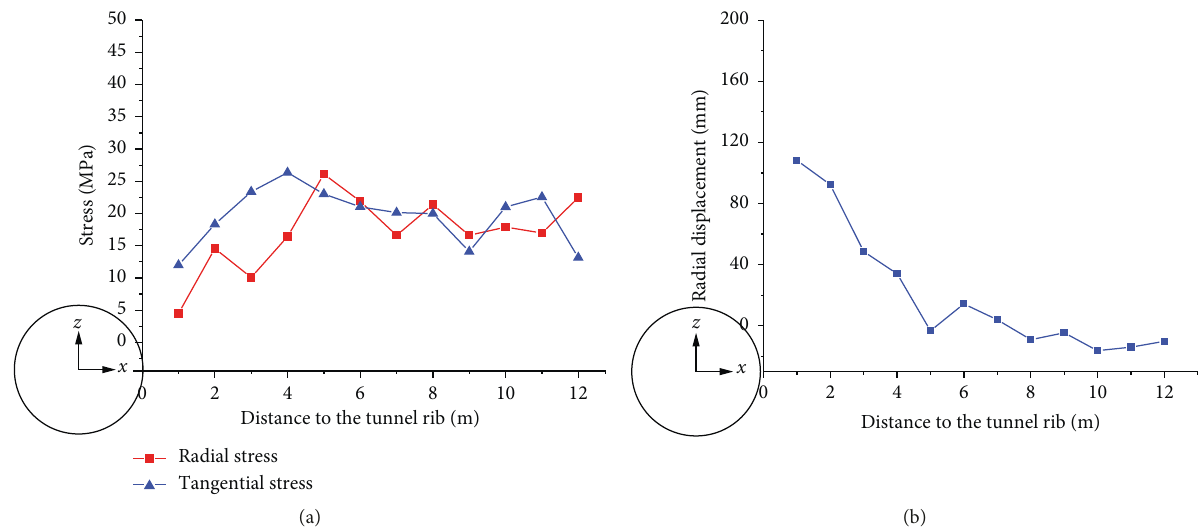
Figure 9: Monitoring results of (a) the stress around the roadway and (b) the radial displacement around the roadway.